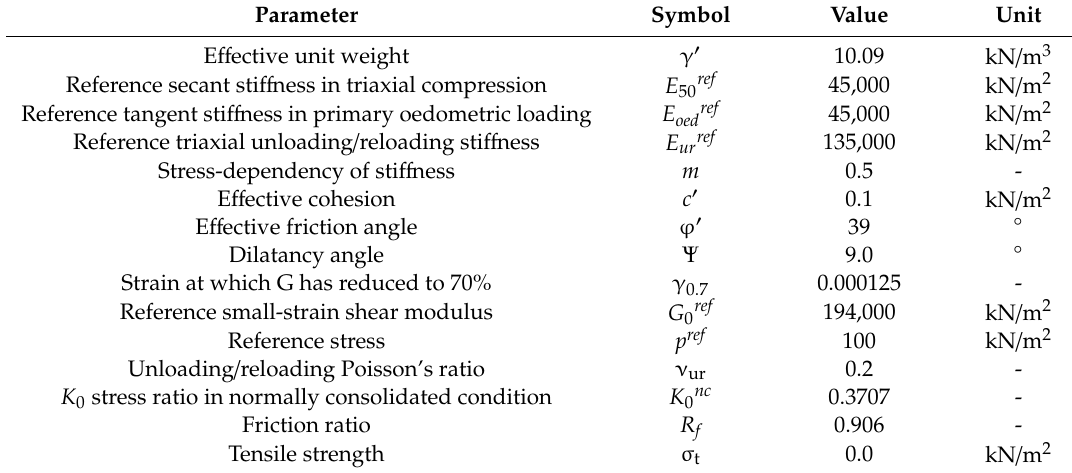
Table 2. Parameters of the Hardening Soil small-strain (HSsmall) model, representing Dunkirk sand with D r = 75%.